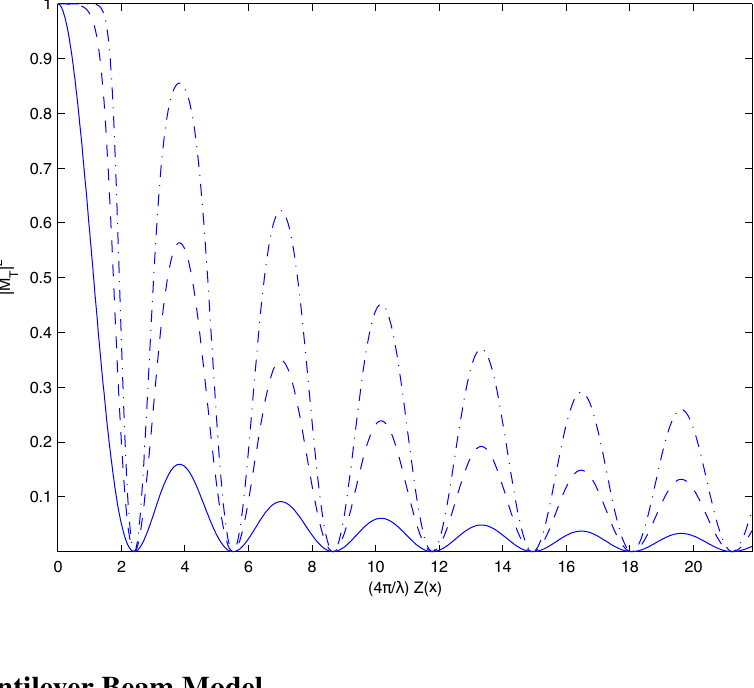
Figure 2. Contrast enhancement of time-averaged holographic fringes: the solid line represents the decay of intensity at increasing amplitude Z ( x ) ; the dashed line shows mapped intensity levels at k = 4 (dashed line) and k = 8 (dash-dotted line).